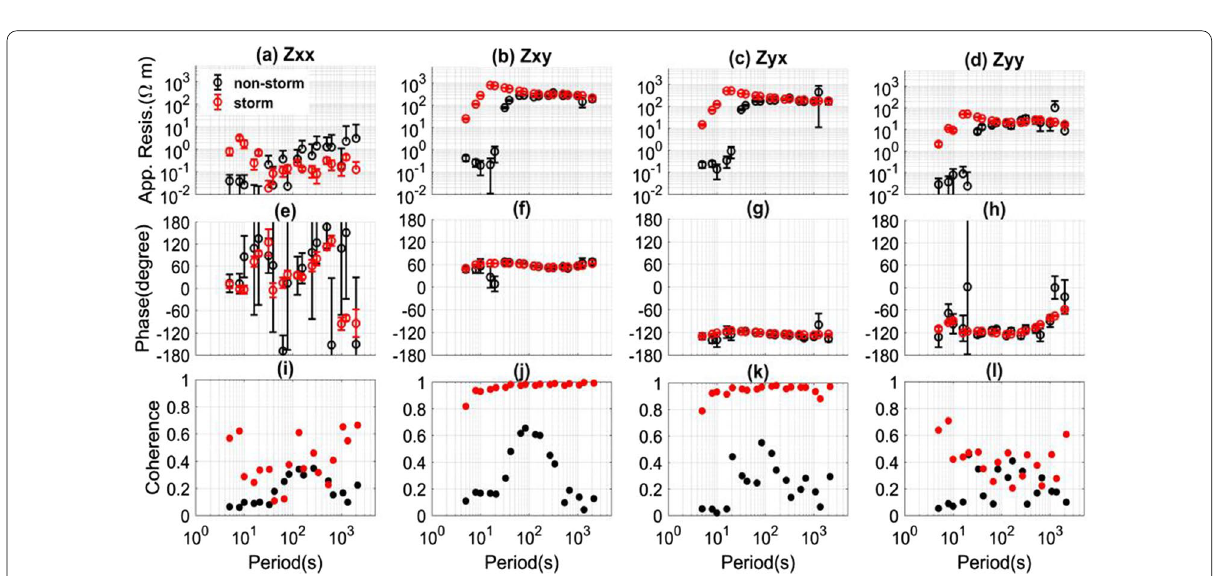
Fig. 15 MT sounding curves and coherence distributions during the storm and non-storm days using the data observed at TNV48 from USArray. The black color indicates the results calculated by non-storm data observed from 00:00 on June 19 to 00:00 on June 21; the red color indicates the results calculated by storm data observed from 00:00 on June 22 to 00:00 on June